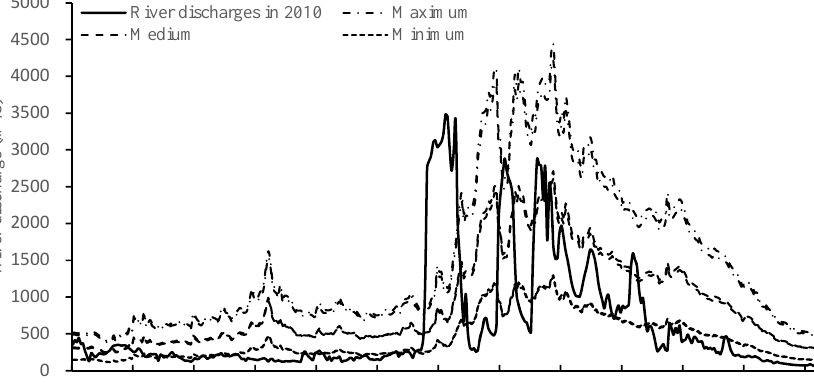
Fig. 7. Daily discharge comparisons during water–sediment regulation, and daily environmental flow in the Yellow River